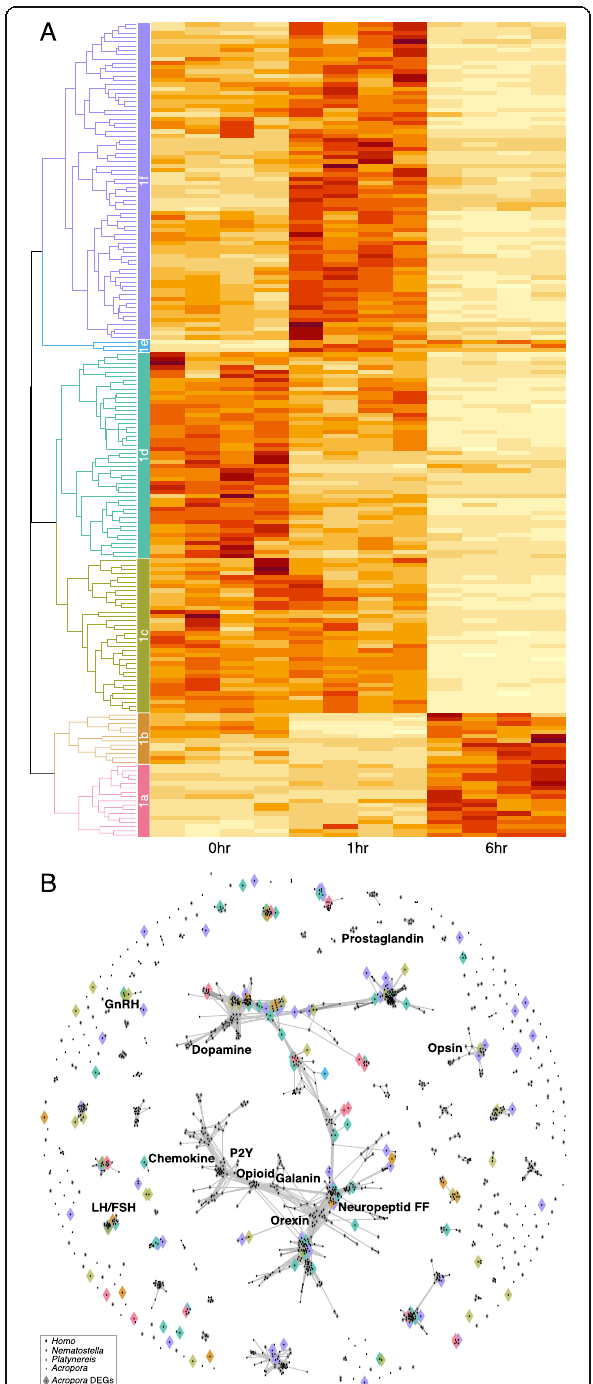
Fig. 2 DEGs in GPCR Family 1 of Acropora tenuis . A Heatmap of gene expression (z score). DEGs were divided into six groups (1a to 1f) according to their expression patterns. B Cluster analysis with Homo sapiens ligand – receptor annotations. Rhombus indicates DEGs of A. tenuis . Rhombus colors correspond to the six DEG groups